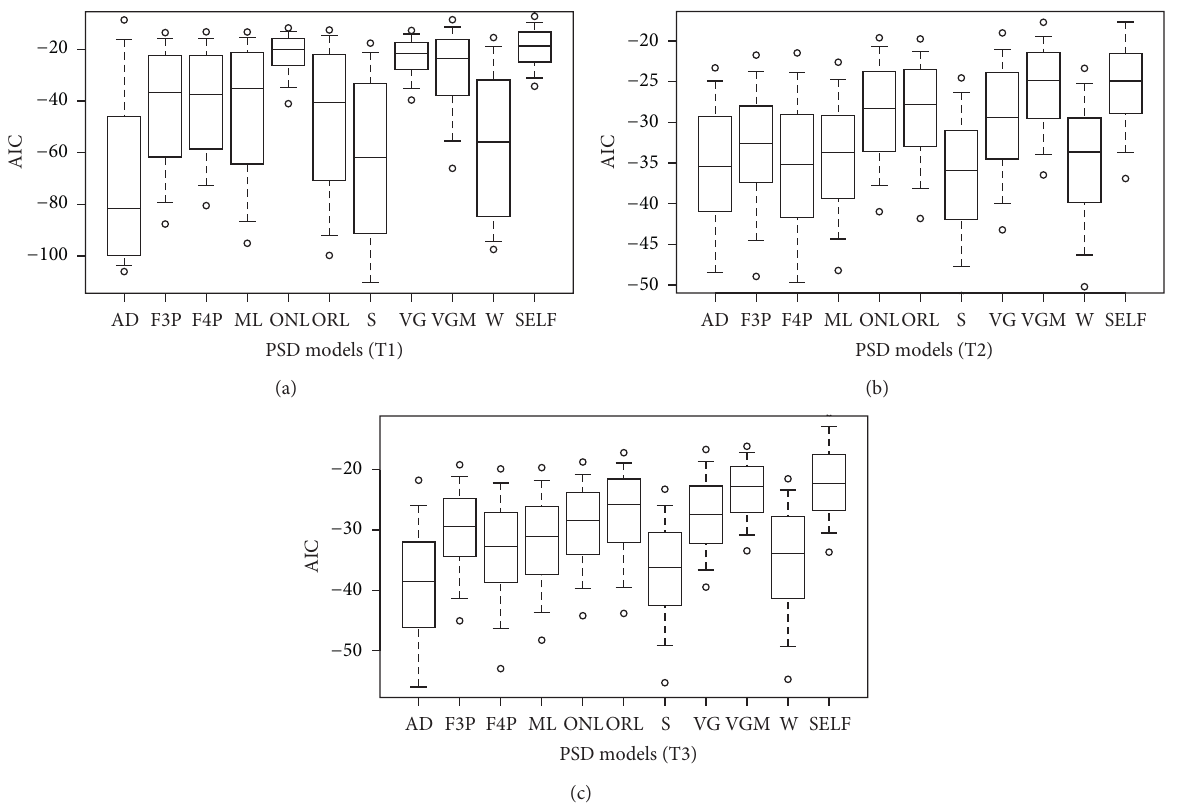
Figure 2: Box plot for Akaike’s information criterion (AIC) percentiles as a criterion for assessing the performance of 11 models, (a) T1 scheme soils, (b) T2 scheme soils, and (c) T3 scheme soils.